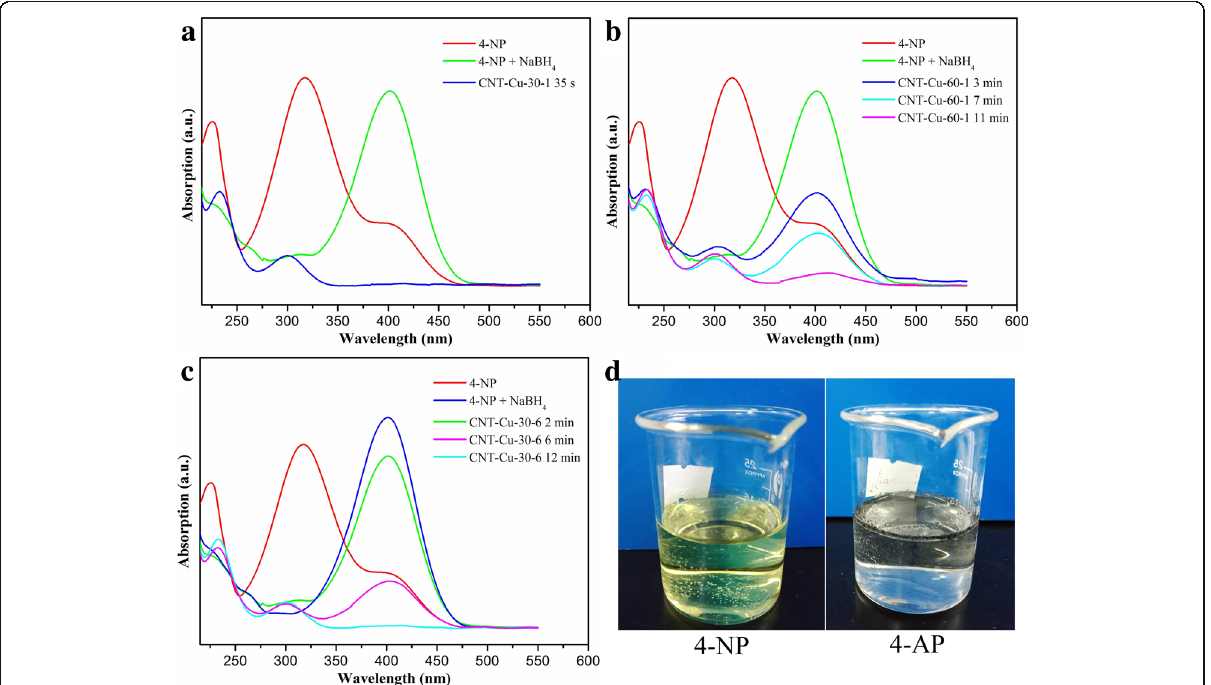
Fig. 5 Catalytic reduction of 4-NP via present synthesized CNT-Cu 2 O nanocomposites. a CNT-Cu-30-1. b CNT-Cu-60-1. c CNT-Cu-30-6. d The photos of 4-NP solution before and after the catalytic